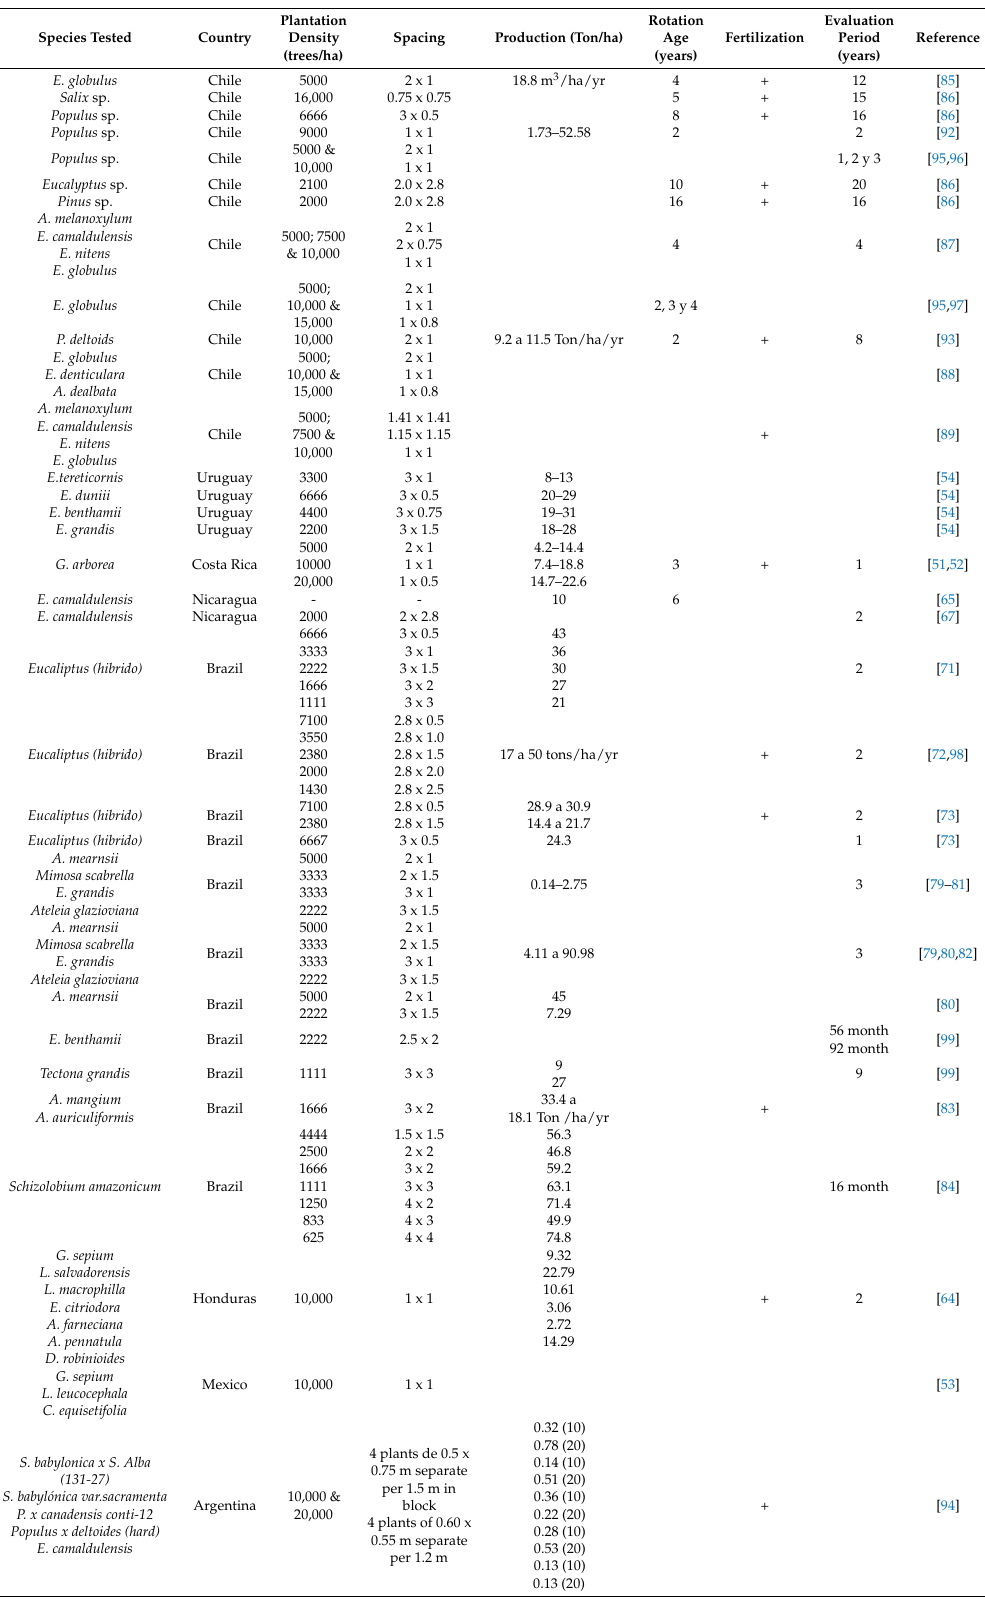
Table 2. Summary of plantation density, spacing, production, height, and diameter of different species of short rotation woody crops utilized in plantations in different countries of Latin